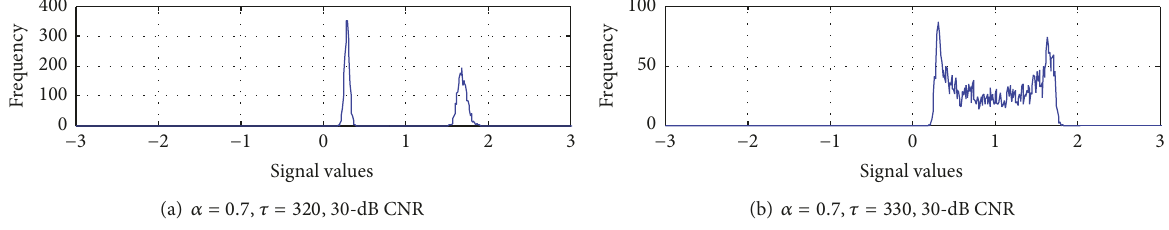
Figure 5: Received signal distributions for long delay waves.